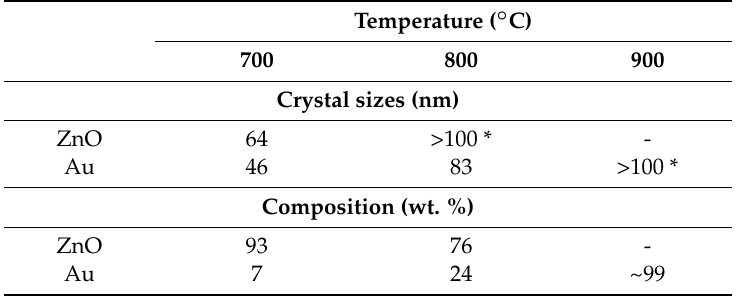
Table 1. Crystal sizes and semi-quantitative phase analysis, as obtained from the XRD